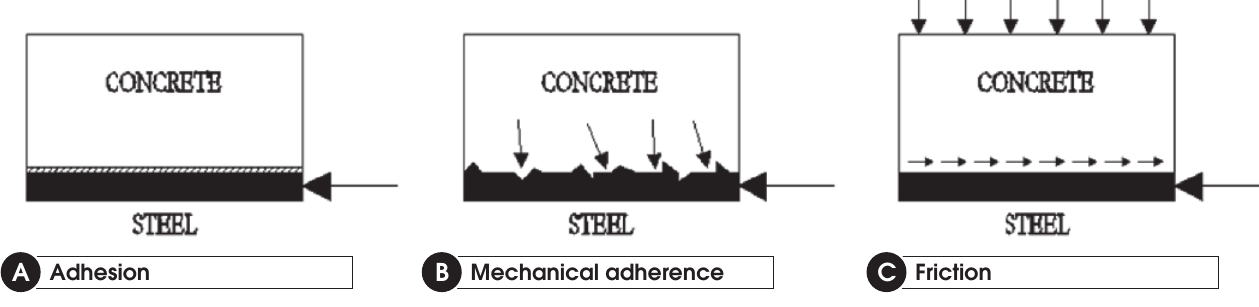
Idealized models of shear transfer in steel - concrete interface. Source: Adapted of [4]